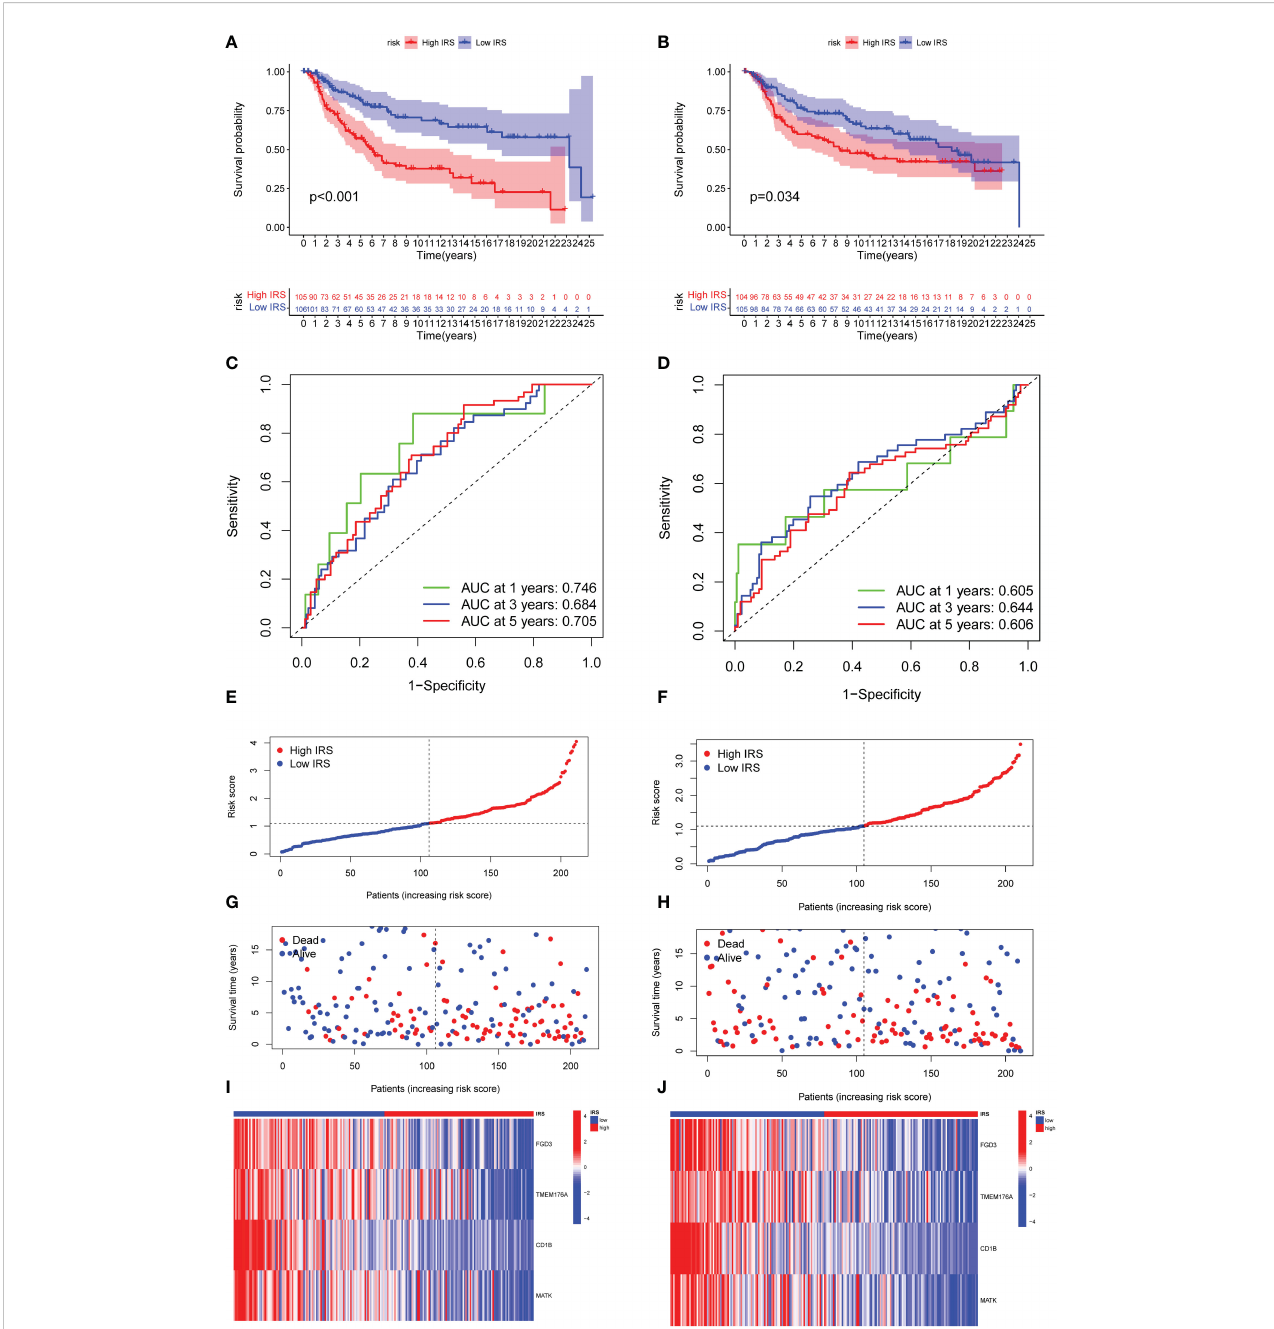
FIGURE 4 Validation of the ef fi cacy of ICGs-related riskscore model. (A, B) Kaplan – Meier curves for OS in TNBC patients according to the riskscore strati fi cation in the training cohort and validation cohort. (C, D) Time-dependent ROC analysis for OS prediction at 1 year, 3 year and 5 year in TNBC patients in the training cohort and validation cohort. (E, F) Distribution of risk score for the training group and validation cohort. (G, H) Distribution of survival time of patients in the training and validation cohort. (I, J) Heatmap depicting the expression of FGD3, TMEM176A, CD1B and MATK between high IRSgroup and the low IRSgroup in training and validation